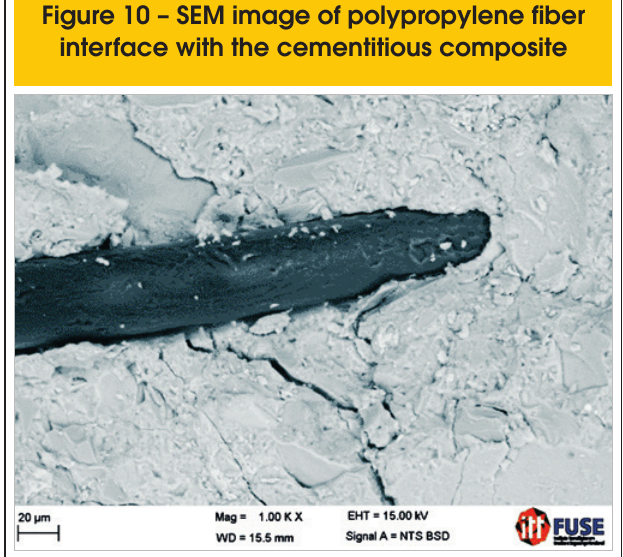
Figure 10 – SEM image of polypropylene fiber interface with the cementitious composite